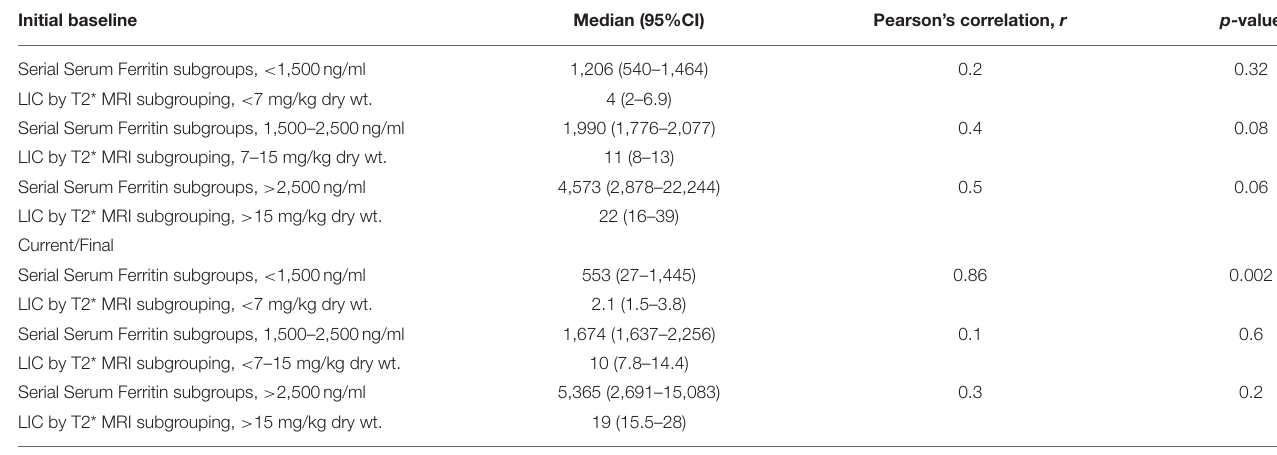
TABLE 3 | Effect of chelation: correlation of liver iron concentration (LIC) with serial serum ferritins in specific subgroups, initial baseline values, and final current values. Initial baseline